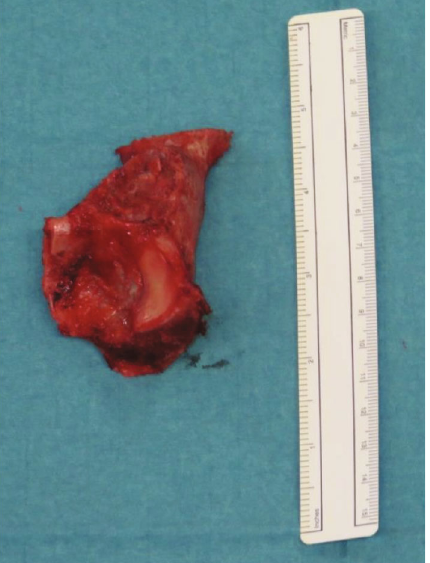
Figure 7: Picture of the resected bone. The tumor on the iliopubic ramus in fi ltrating the anterosuperior portion of the acetabulum is visible.